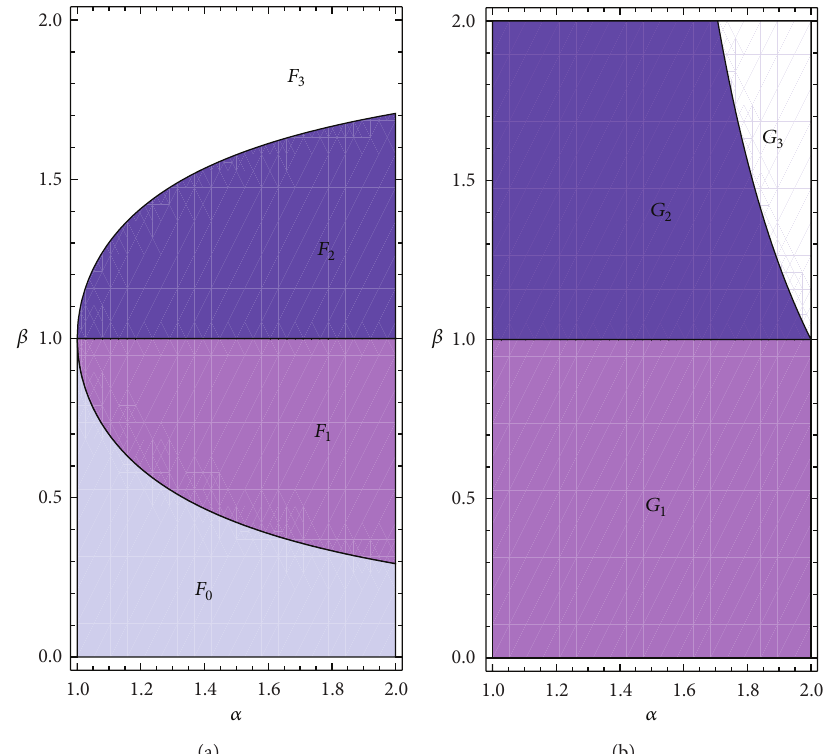
Figure 1: Parametric regions for the composition maps 𝐹 𝛼,𝛽 (a) and 𝐺 𝛼,𝛽 (b) according to the number of pieces of monotonicity.